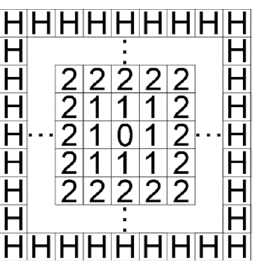
Figure 7. Square mask M( x ) with length from 0 to H .